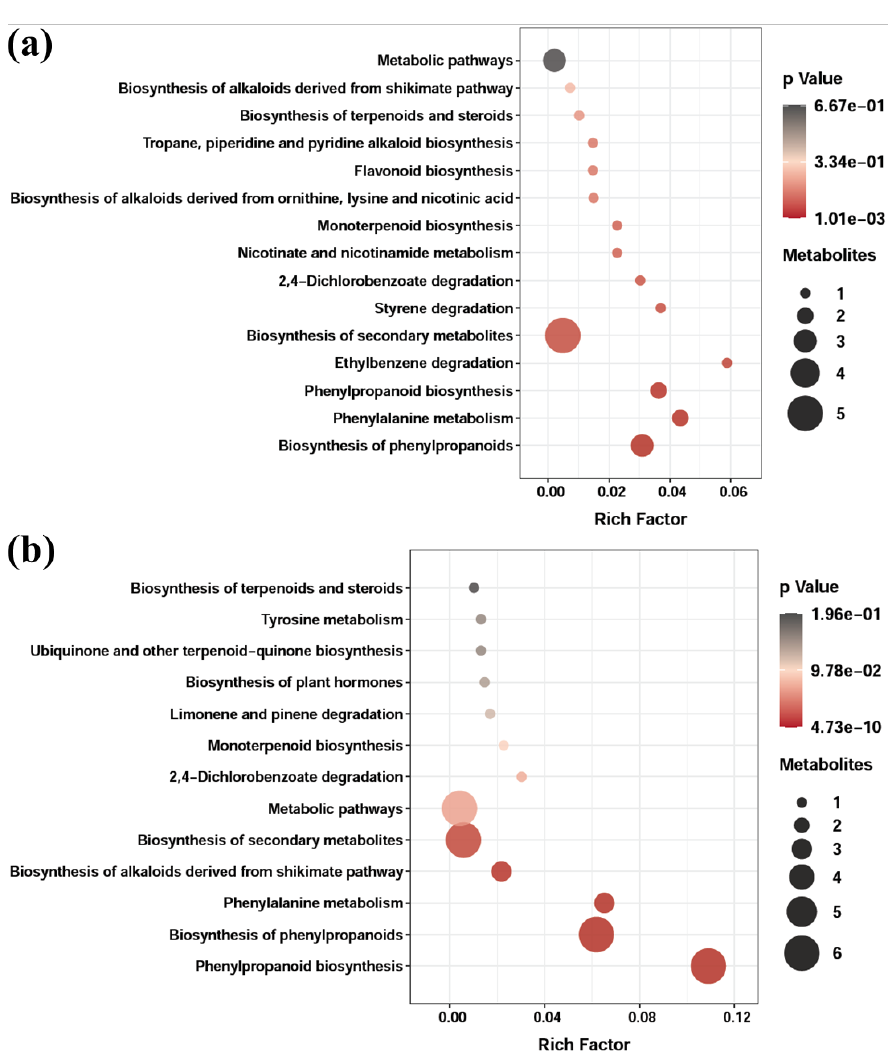
Figure 5. Scatter plot of the KEGG pathway analysis of differentially regulated metabolites present in EAE-PL ( a ) and EAE-PR ( b ). The X-axis denotes the Rich Factor (the ratio of the number of differentially regulated metabolites annotated in a pathway indicated on the Y-axis), and the Y-axis denotes the name of the pathways. The color of the bubbles represents the significance of the regulation at the magnitude of the p